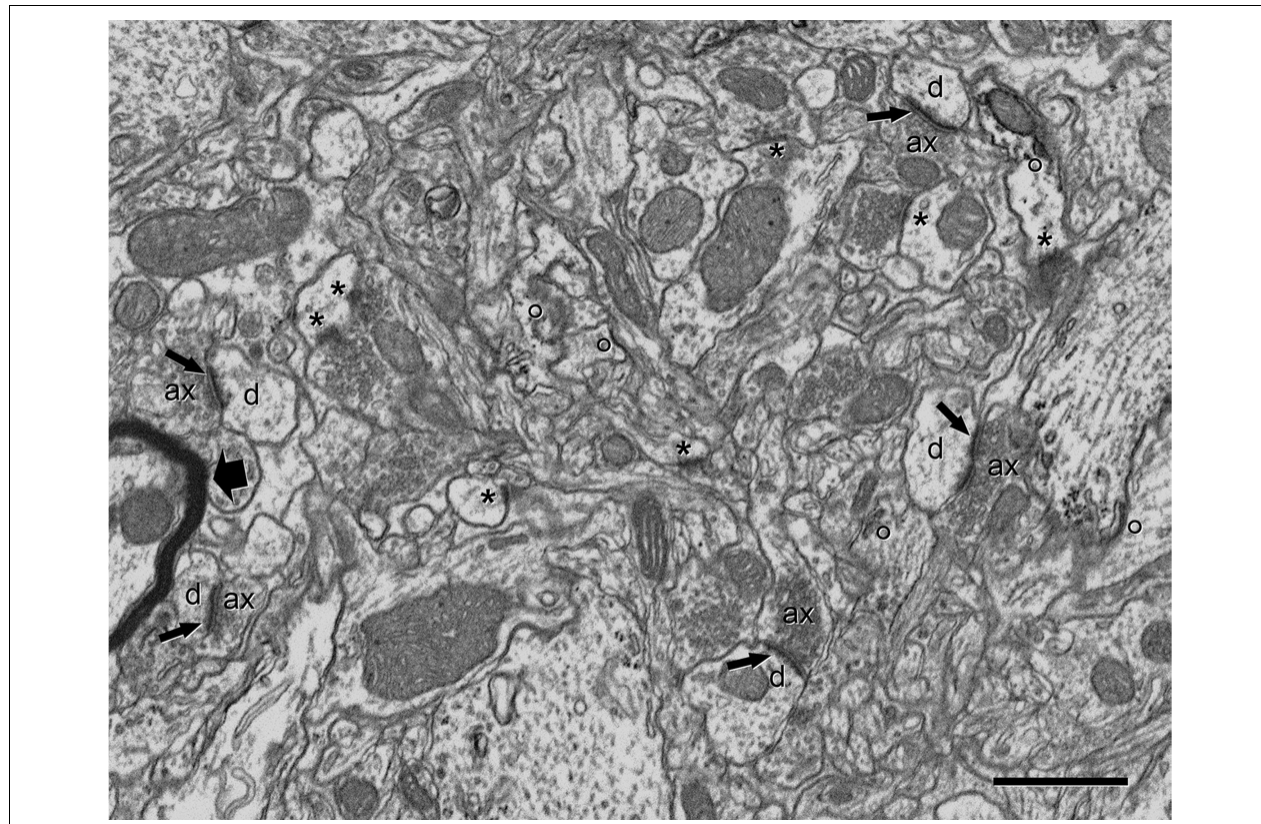
FIGURE 2 | Panoramic view of the neuropil obtained in backscattered electron imaging mode. The high quality of the image is comparable to the images obtained with TEM. Intracellular structures such as fi laments, vesicles, cisternae or mitochondria can be identifi ed. Some axon terminals (ax) establish clearly identifi able asymmetric synapses (arrows) with dendritic spines (d).